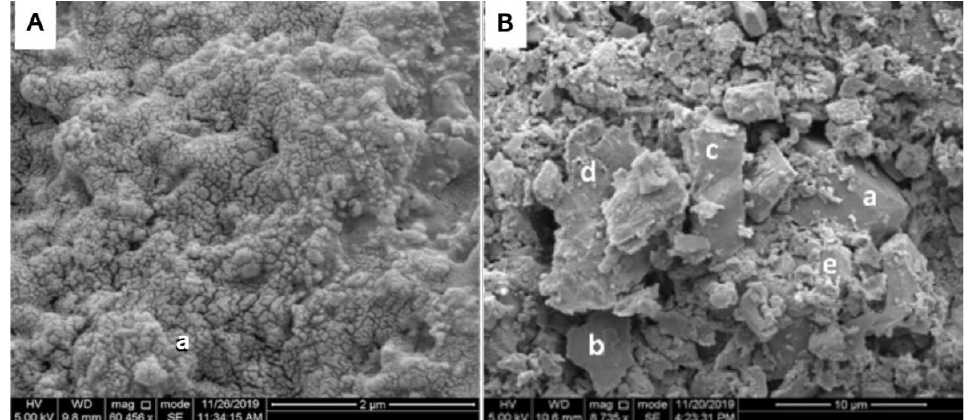
Figure 5. Back-scattered SEM images of ( A ) phosphorite sample HOP-5, and ( B ) bituminous limestone marl sample OS-3. Both show distinct textural, crystallization, and alteration features detailed in Appendices E and F. ( A ) HOP-5 sample with fine-grained aggregate clusters of mixed mineral phases of apatite, calcite, and amorphous organic matter (spot a; Figure A15) (scale bar is 2 µ m). ( B ) OS-3 with coarser calcite crystal (spot a; Figure A13) with signs of dissolution, and fine-grained aggregate clusters of secondary minerals (spots b, c, d, and e) identified as containing a mixture of calcite, dolomite, and silica, with minor amounts of apatite, feldspar, and clay (scale bar is 10 µ